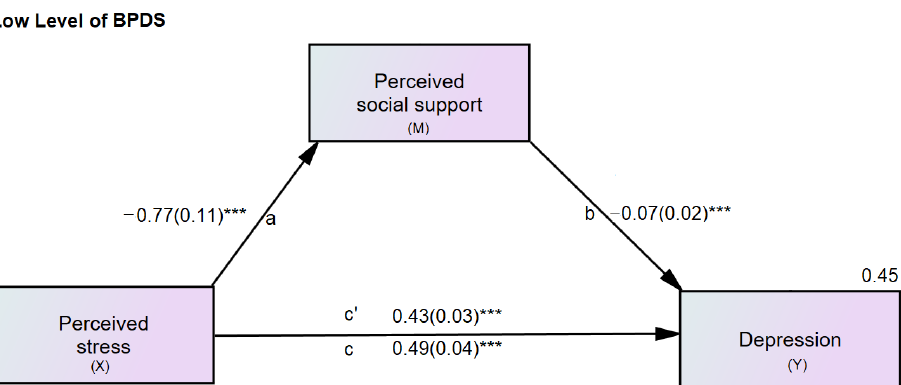
Figure 3. Mediation model of perceived stress, social support, and depression for high levels of borderline personality symptoms. X = predictor; M = mediator; Y = outcome; a, b, c, c’ = path coeffi- cients; c = total direct effect of perceived stress on depression; c’ = direct effect of perceived stress on depression controlling for perceived social support. Values for depression (Y) are the R-square. BPDS = borderline personality disorder symptoms. *** p < 0.001.